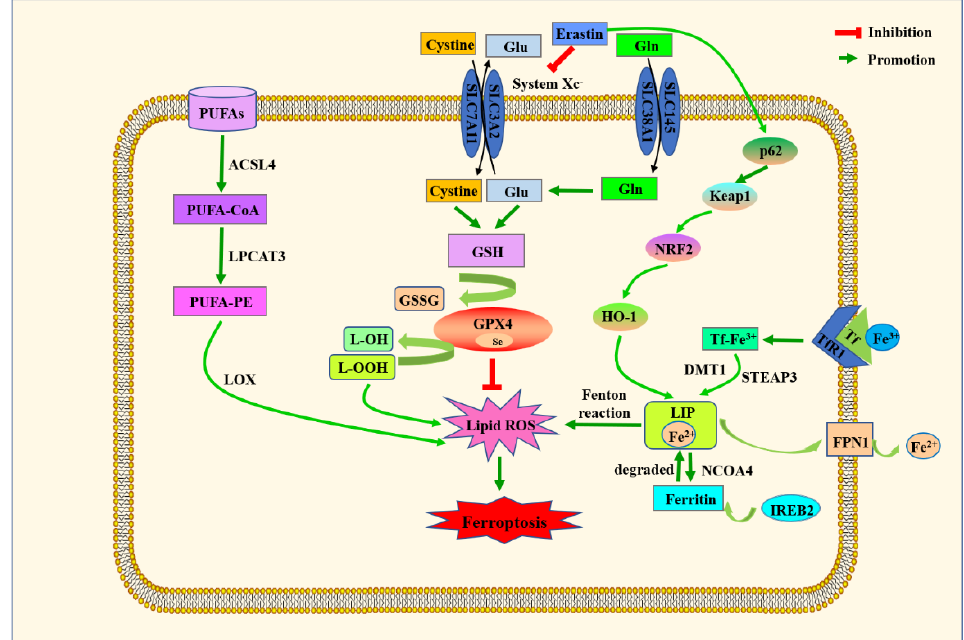
Figure 4. Mechanisms of ferroptosis. Ferroptosis is characterized by iron accumulation, excessive ROS production and overwhelming lipid peroxidation. This figure shows the regulatory pathways of ferroptosis, which are roughly divided into three categories: amino-acid/GSH, lipid and iron pathways.